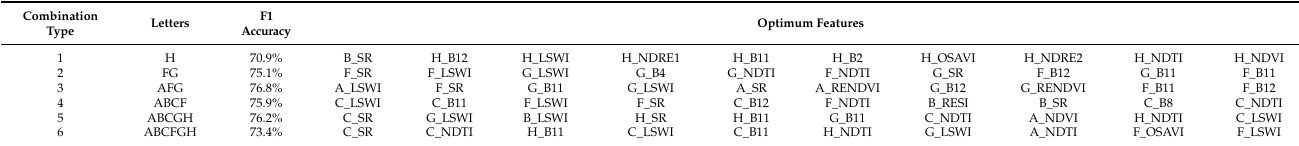
Table A5. Top-10 optimal corn feature sets for different combination types on 28 May 2020.